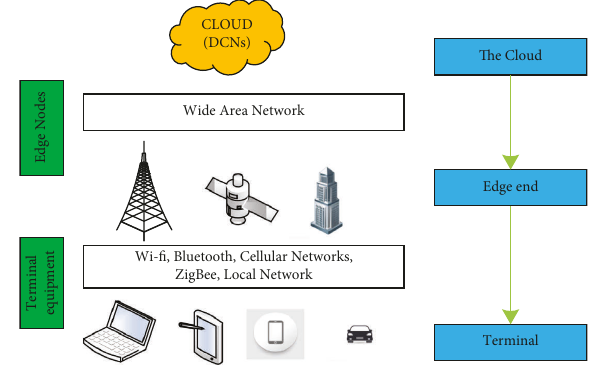
Figure 1: Logic structure diagram of the edge